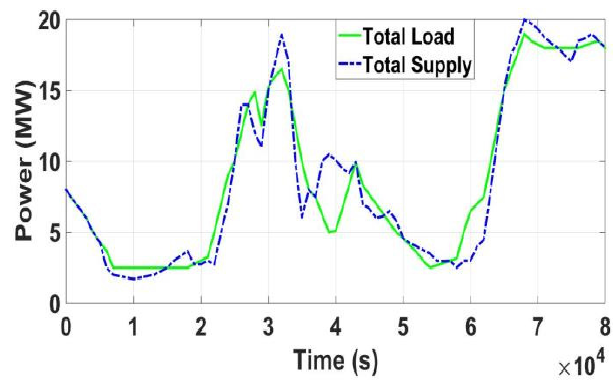
Figure 8. Hourly-based random load of industrial microgrid.